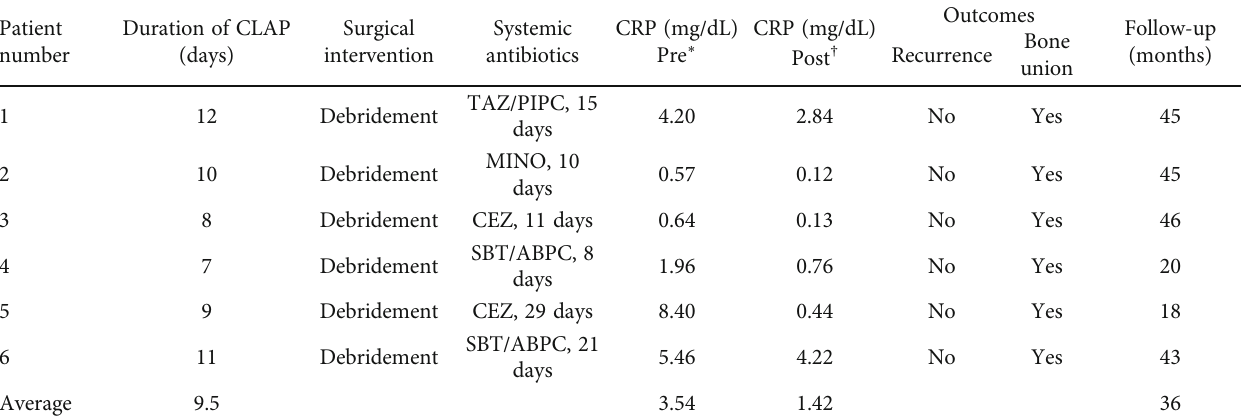
Table 2: Summary of management and clinical results.